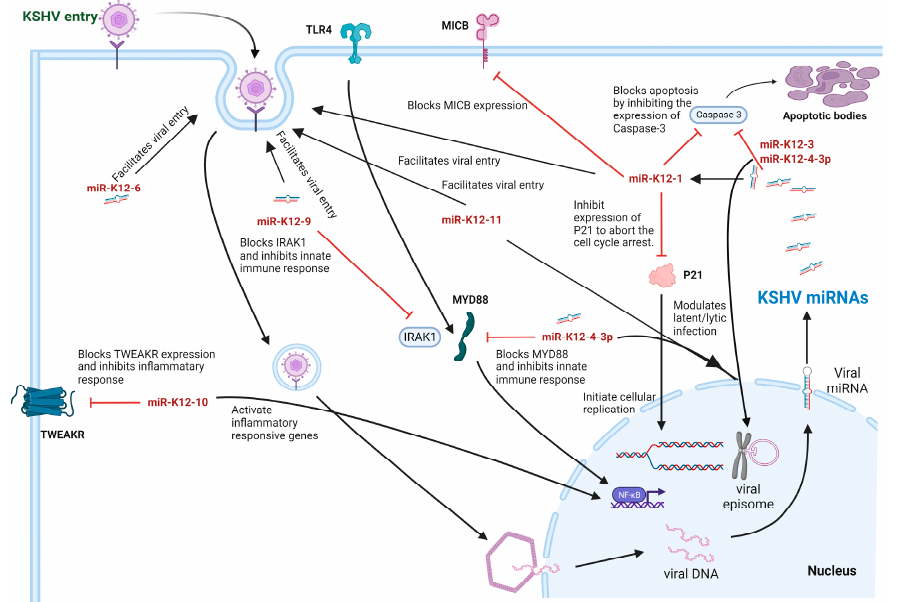
Figure 5. KSHV miRNA: Kaposi’s sarcoma-associated herpesvirus (KSHV)-encoded miRNAs exhibit dysregulation of host signaling pathways. The viral miRNAs block apoptosis by inhibiting the gene expression of caspase-3 protein, modulating latent/lytic infection by facilitating viral genome integration into the host chromosome and aborting the cell-cycle arrest by inhibiting the P21 protein synthesis to initiate cellular replication. KSHV miRNA blocks MYD88 activity, thereby inhibiting the innate immune response against the virus. Several miRNAs are reported to facilitate viral entry by modulating expression of several host